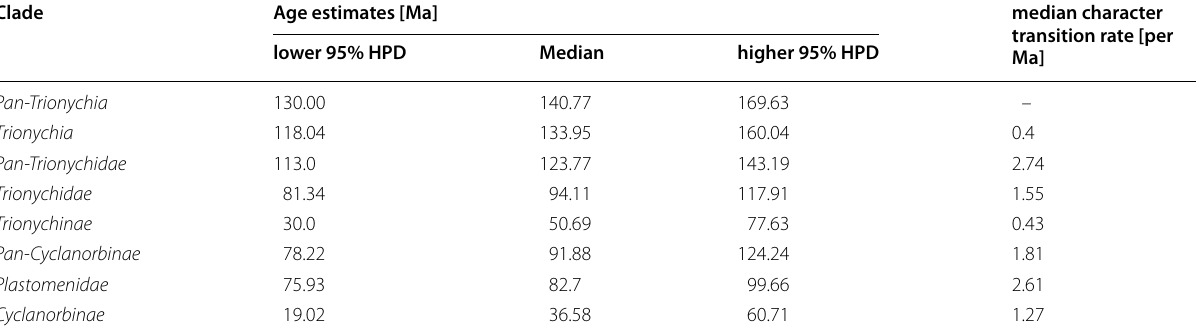
A list of all node age estimates and evolutionary rates is provided in Additional file 7: Data 6. HPDs are highest posterior densities